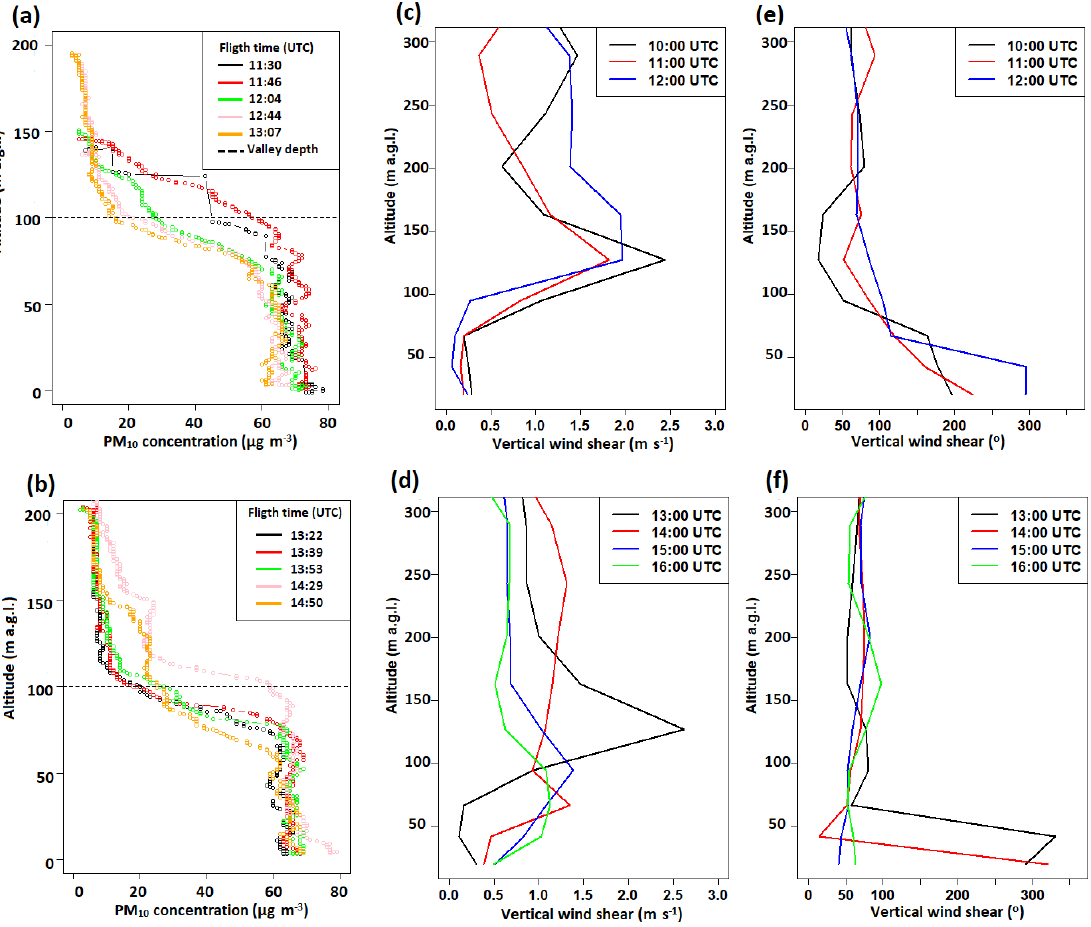
Figure 10. Vertical profiles of PM 10 concentration (a–b) and vertical profiles of wind shear speed (c–d) and direction (e–f) on 28 Novem- ber 2019. Explanation: valley depth is the altitude of the hilltops surrounding the valley marked at 100ma.g.l. with a dashed line in (a) and (b)